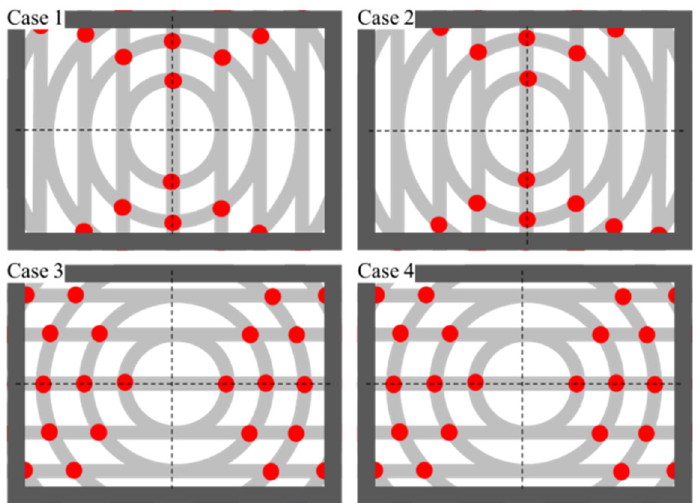
Figure 4. There are four angle detection results without offset ( 𝛥𝑠 = 0 ) Case1: 0°; Case2: 180°; Case3: 90°; Case4: 270°.